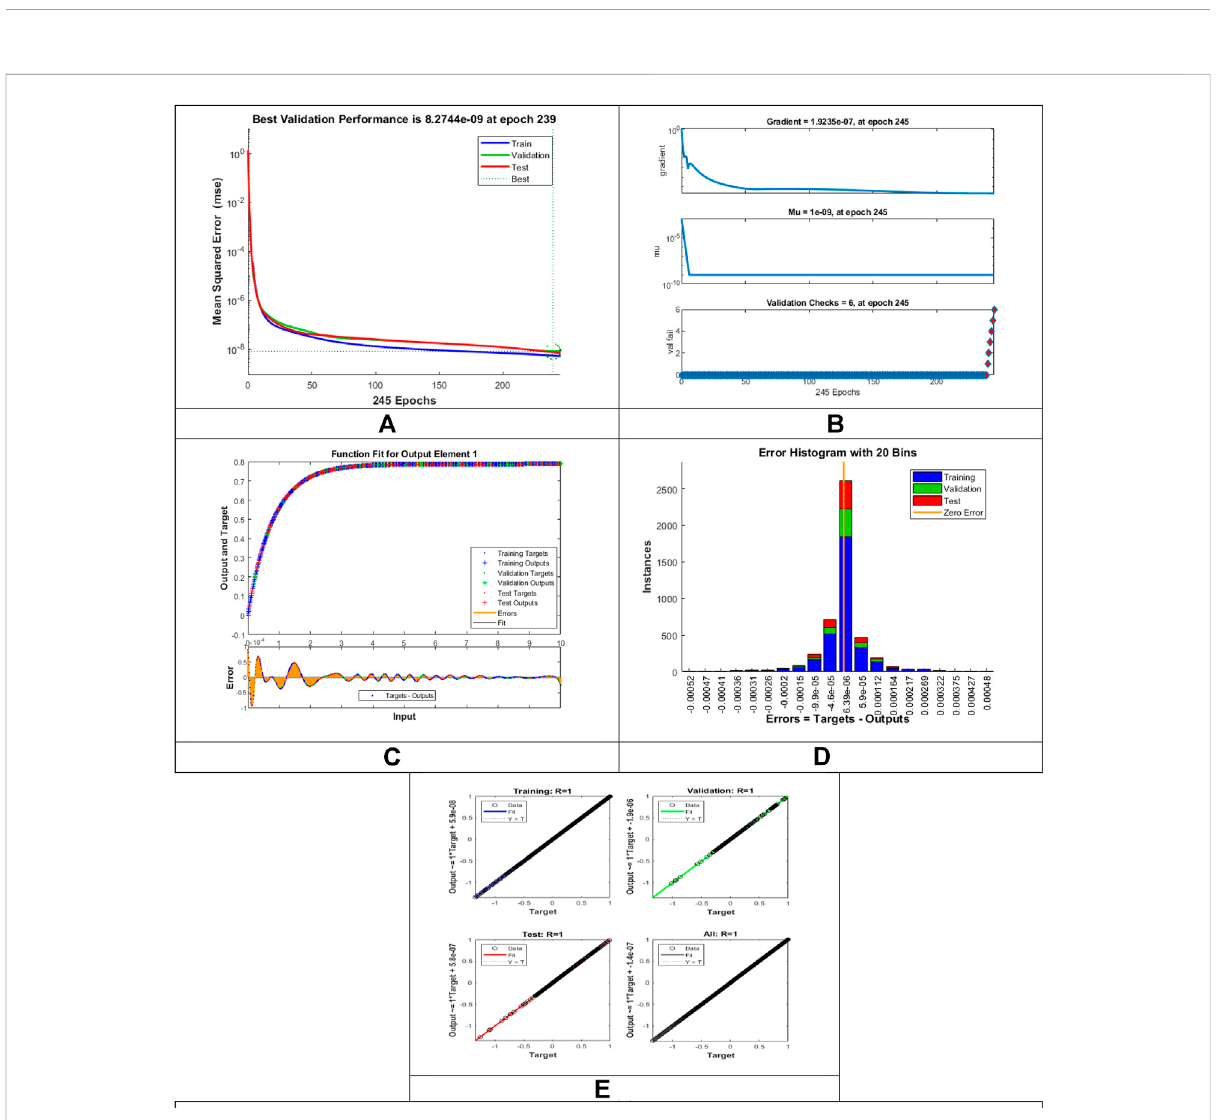
FIGURE 5 Pictorial illustration for the LMLA-BPNN base on variants of Davsf ′ ( η ) MHD-WNF-HGA. (A) M-S-E demonstration, (B) transition state analysis, (C) curve fi tting, (D) error histogram, and (E)